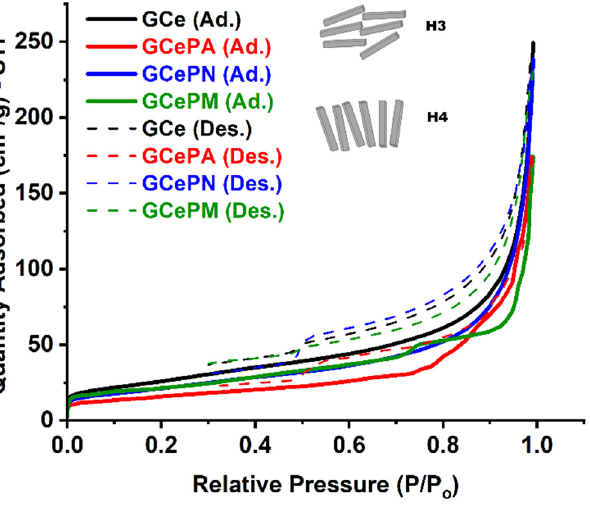
Figure 10. Adsorption-desorption isotherms of all monoliths: GCe (black), GCePA (red), GCePN (blue), and GCePM (green). (blue), and GCePM